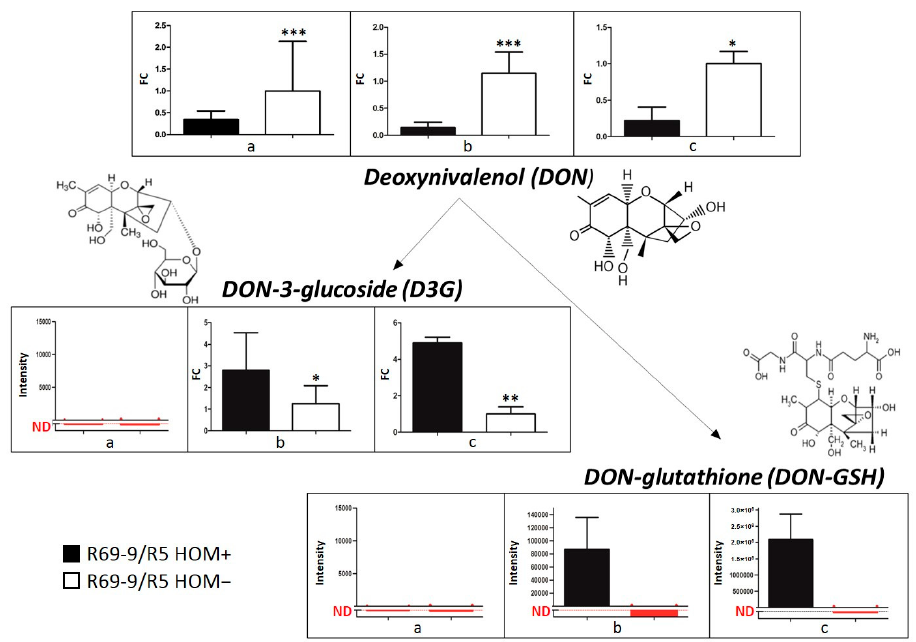
Figure 11. Relative quantities (FC, intensity) of DON and its D3G and DON–GSH conjugates in HOM+ and HOM − Fg -inoculated rachises at 2 dpi ( a ) and 4 dpi ( b ), and in mature grains ( c ). Red do tt ed lines indicate no detection (ND), i.e., the metabolite is not present or present in minimal amounts, not distinguishable from the instrument’s background noise. At each time point × tissue combination, the data of HOM+ vs. HOM − Fg -inoculated samples were analysed using Student’s t -test at p < 0.05 *, 0.01 ** and 0.001 *** signi fi cance levels. Arrows indicate possible DON biotransformations.